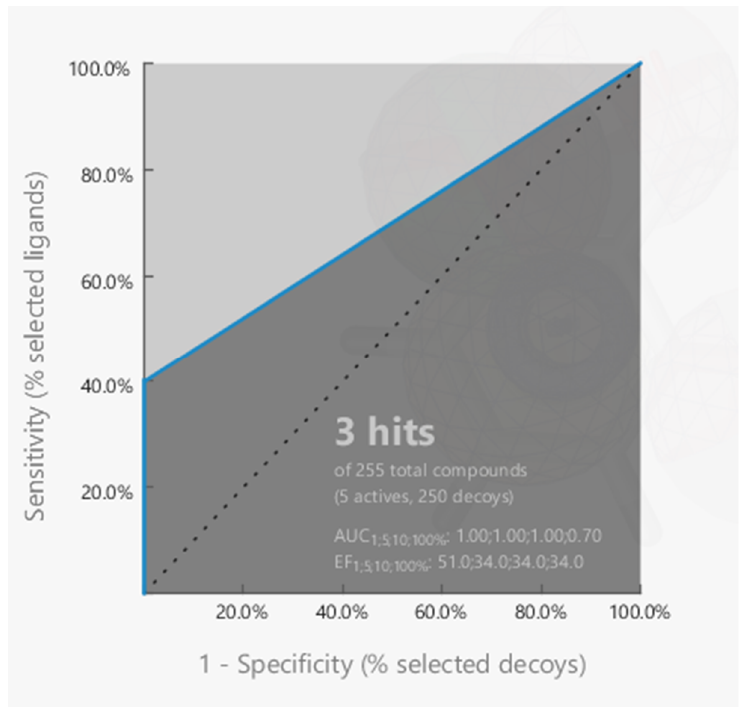
Figure 3. Selected pharmacophore model ROC curve indicated in blue. Determined at 1, 5, 10 and 100% of the selected database were the AUC and EF values as shown. The median is shown by dotted lines. If the curve were to be close to the median, then it would suggest a poor model.